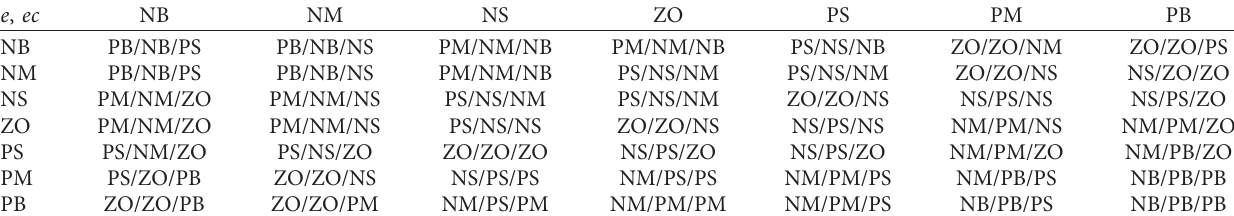
Table 2: Fuzzy rule setting for K